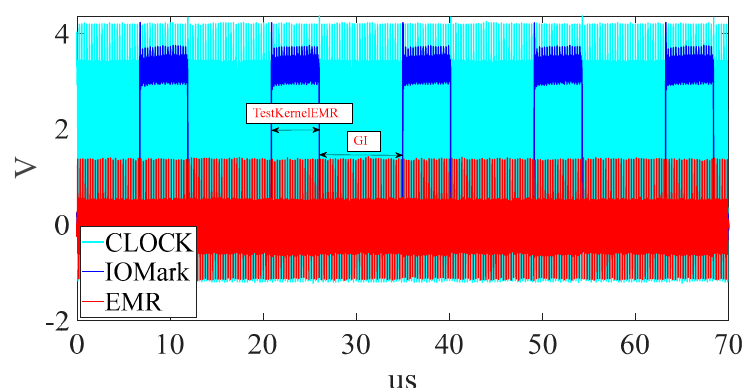
Figure 11. The measurement of the proposed platform.